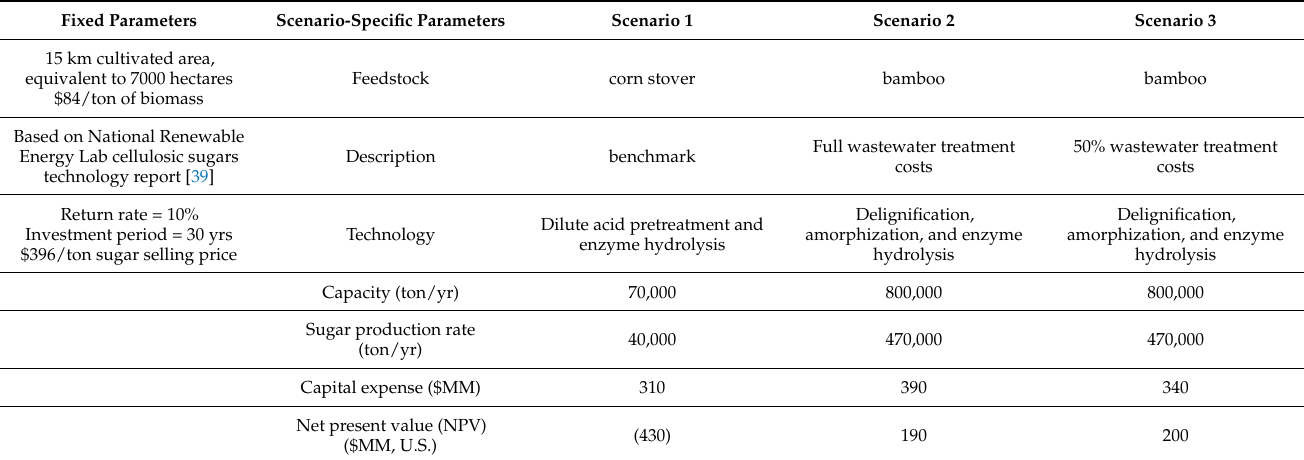
Table 2. Techno-economic analysis of biorefineries based on corn stover (benchmark) and